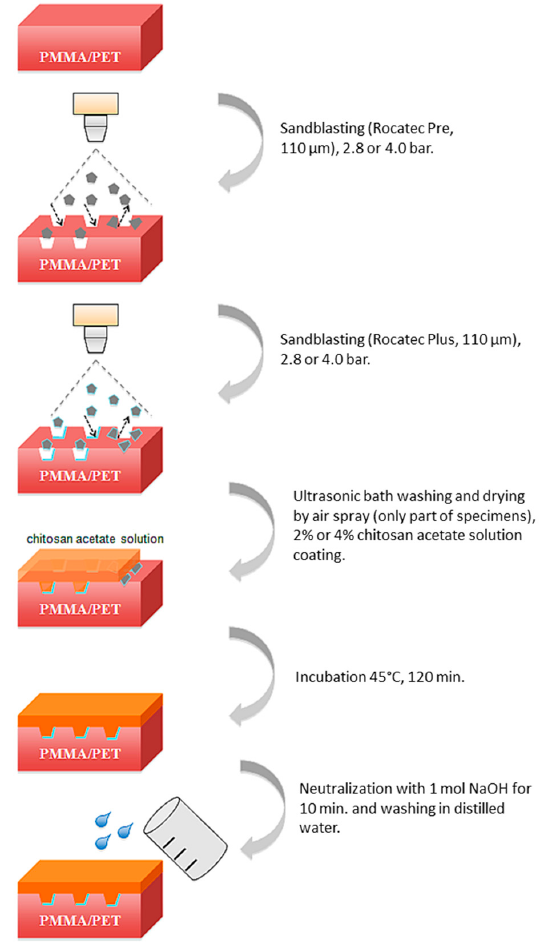
Figure 2. Illustration of workflow to coat resin specimens with CS.